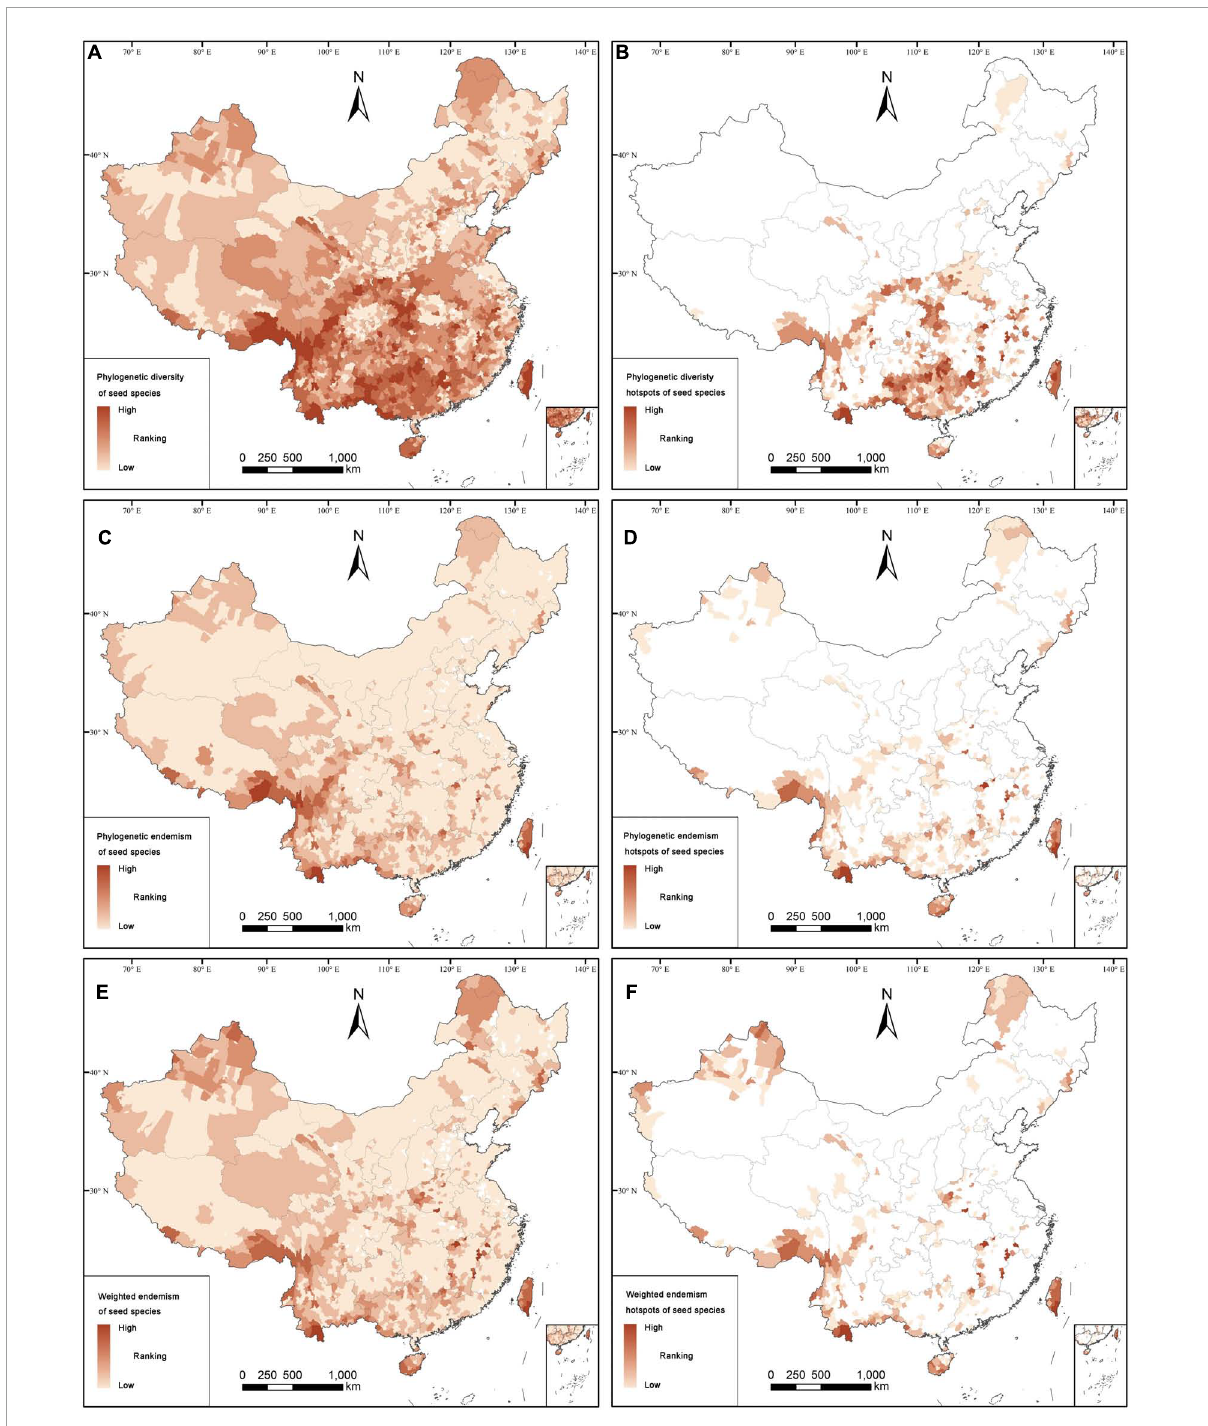
FIGURE2 Distribution patterns of phylogenetic diversity [PD (A,B) ], phylogenetic endemism [PE (C,D) ], and weight endemism [WE (E,F) ]. The top 17% of land area with highest values of PD (B) , PE (D) , and WE (F) for seed plant species.